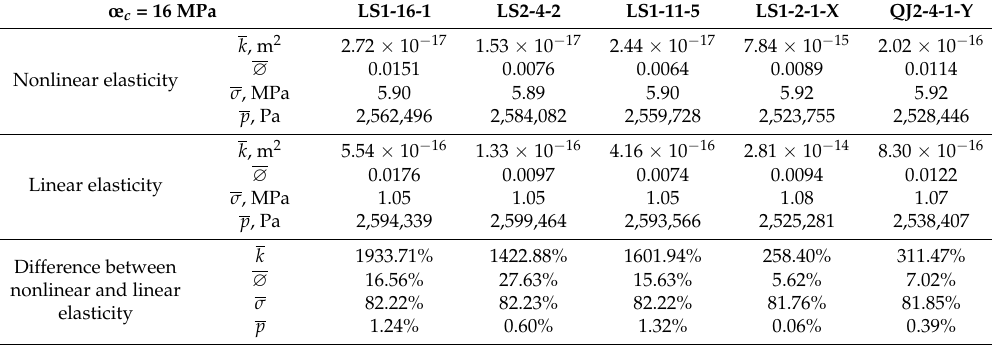
Table 5. Average property values for confining stress of 16 MPa and comparison with the linear elasticity case.